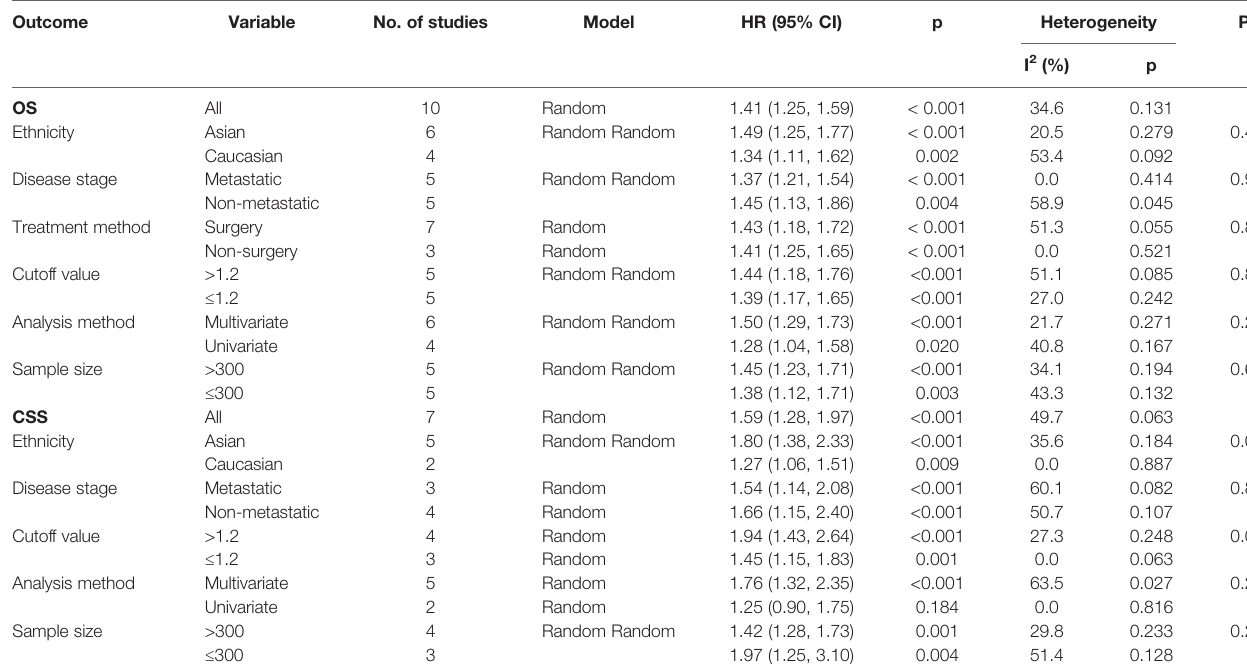
TABLE 2 | Subgroup analyses of OS and CSS.